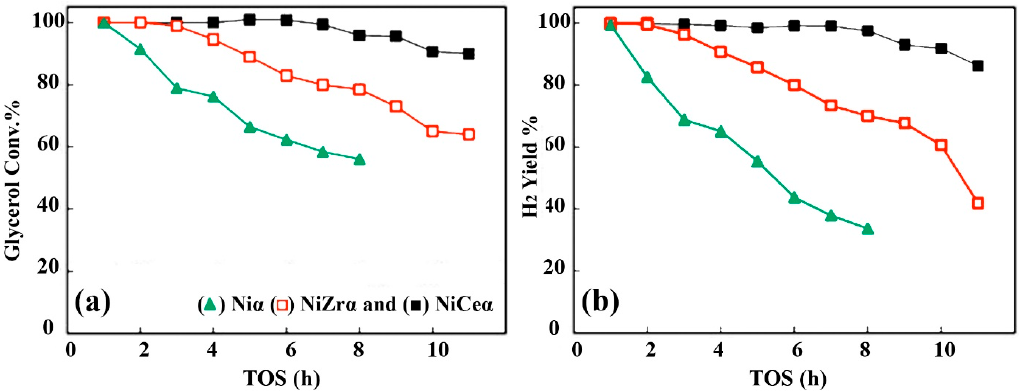
Figure 3. Stability tests at 600 °C of the studied catalysts, ( a ) glycerol conversion, and ( b ) H 2 yield% [61] (redrawn with copyright permission).